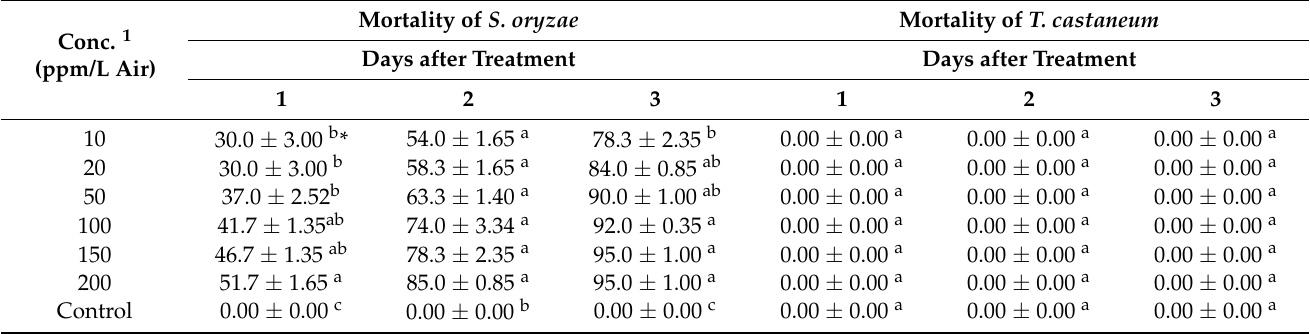
Table 8. Mortality ( ± SD) of S. oryzae and T. castaneum adults following the fumigation bioassay of R. officinalis oil.